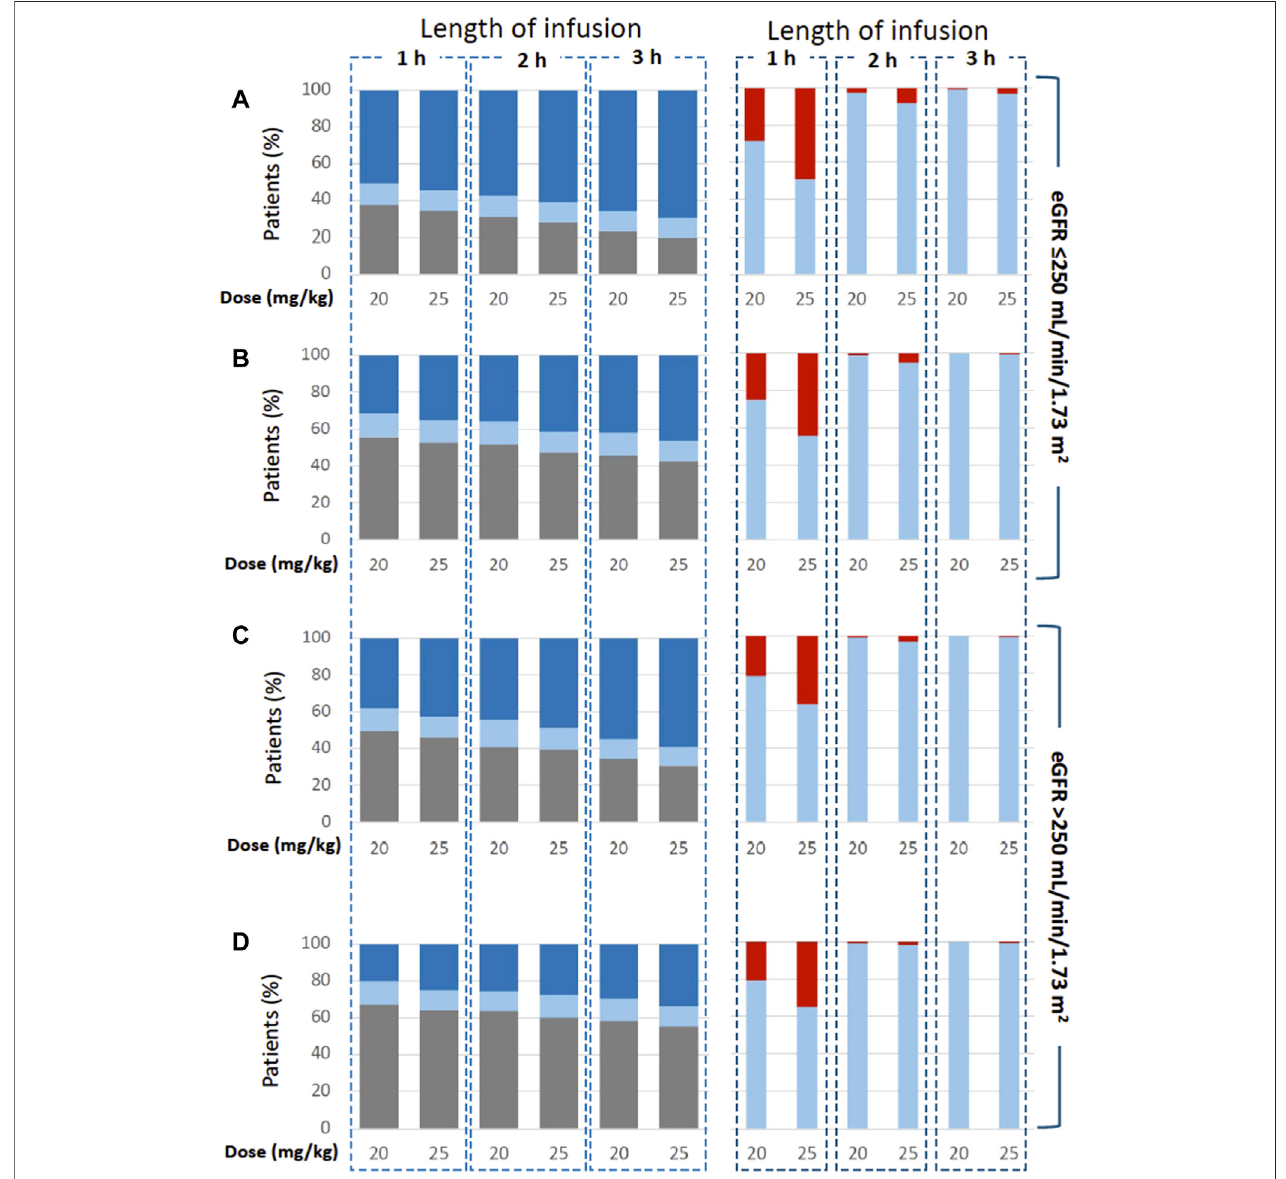
FIGURE5| Simulated regimensconsisting inACV 20or 25 mg/kgadministered as1-h, 2-hand3-hinfusionevery6 h[graphs (A,C) ]and8 h [graphs (B,D) ].Plots show the probability of target attainment (on the left) according to C min values < 0.56 (grey), ≥ 0.56- < 1.125 (pale blue) and > 1.125 mg/L (blue). Moreover, graphs show the probability of achieving C max values < 25 (pale blue) and > 25 mg/L (red).